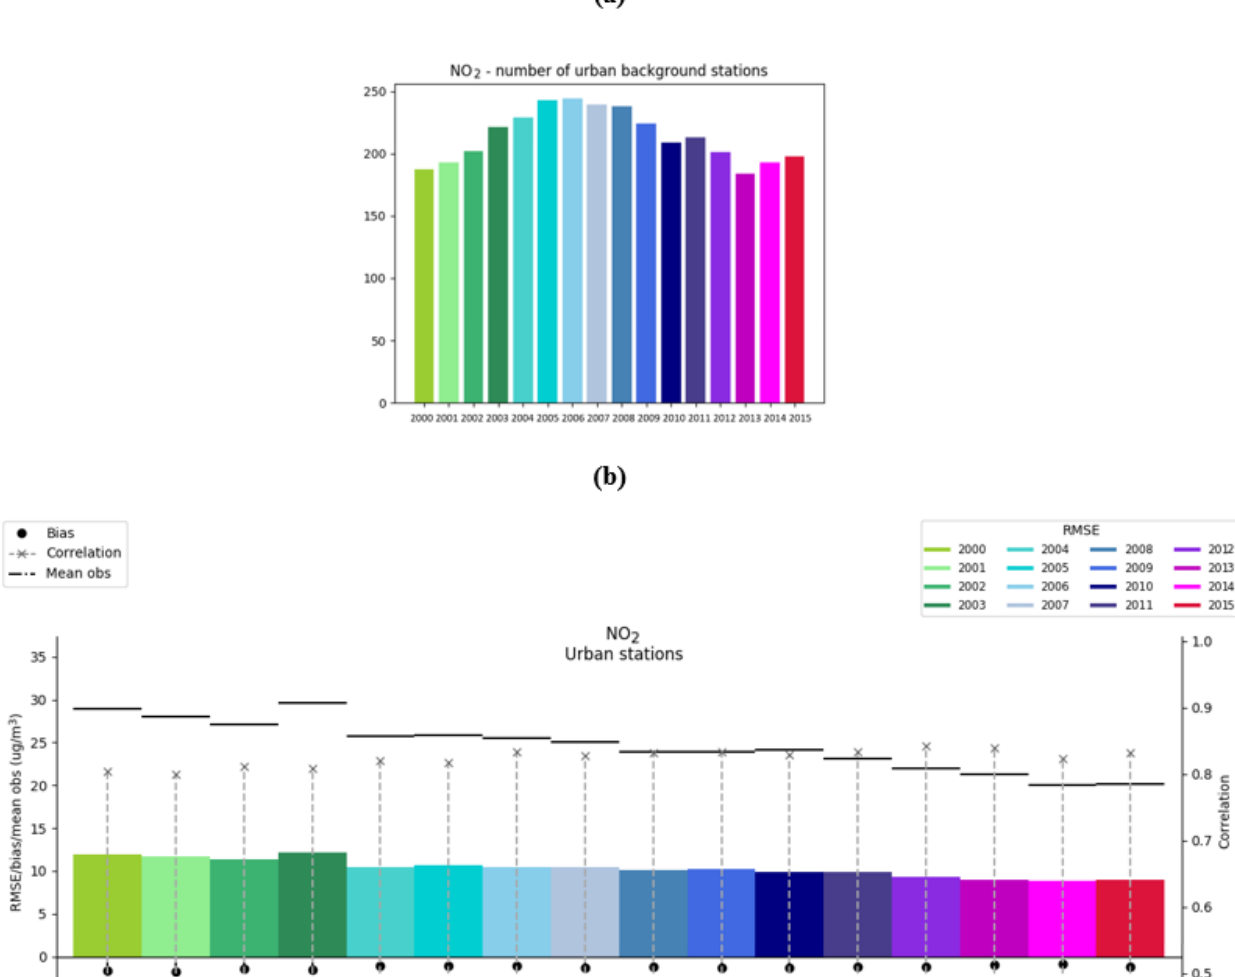
Figure 8. NO 2 : statistical indicators calculated using cross-validation technique on daily mean NO 2 values measured and estimated over URBAN background stations for the years 2000 to 2015. (a) Number of urban stations for each year. (b) Bias (black circles), RMSE (colored rectangles), correlation (grey crosses and the associated dashed lines) and mean observation (horizontal